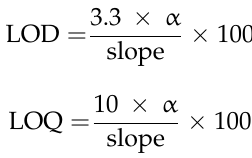
( b ) Figure 3. Electrochemical characterization of the electrodes in a 0.2 mol L − 1 PBS (pH 7.4) solution having 0.1 mol L − 1 of KCl and 5.0 mmol L − 1 of the redox couple Fe[(CN) 6 ] 3 − /4 − by ( a ) Cyclic Voltammetry; ( b ) Electrochemical Impedance Spectroscopy.